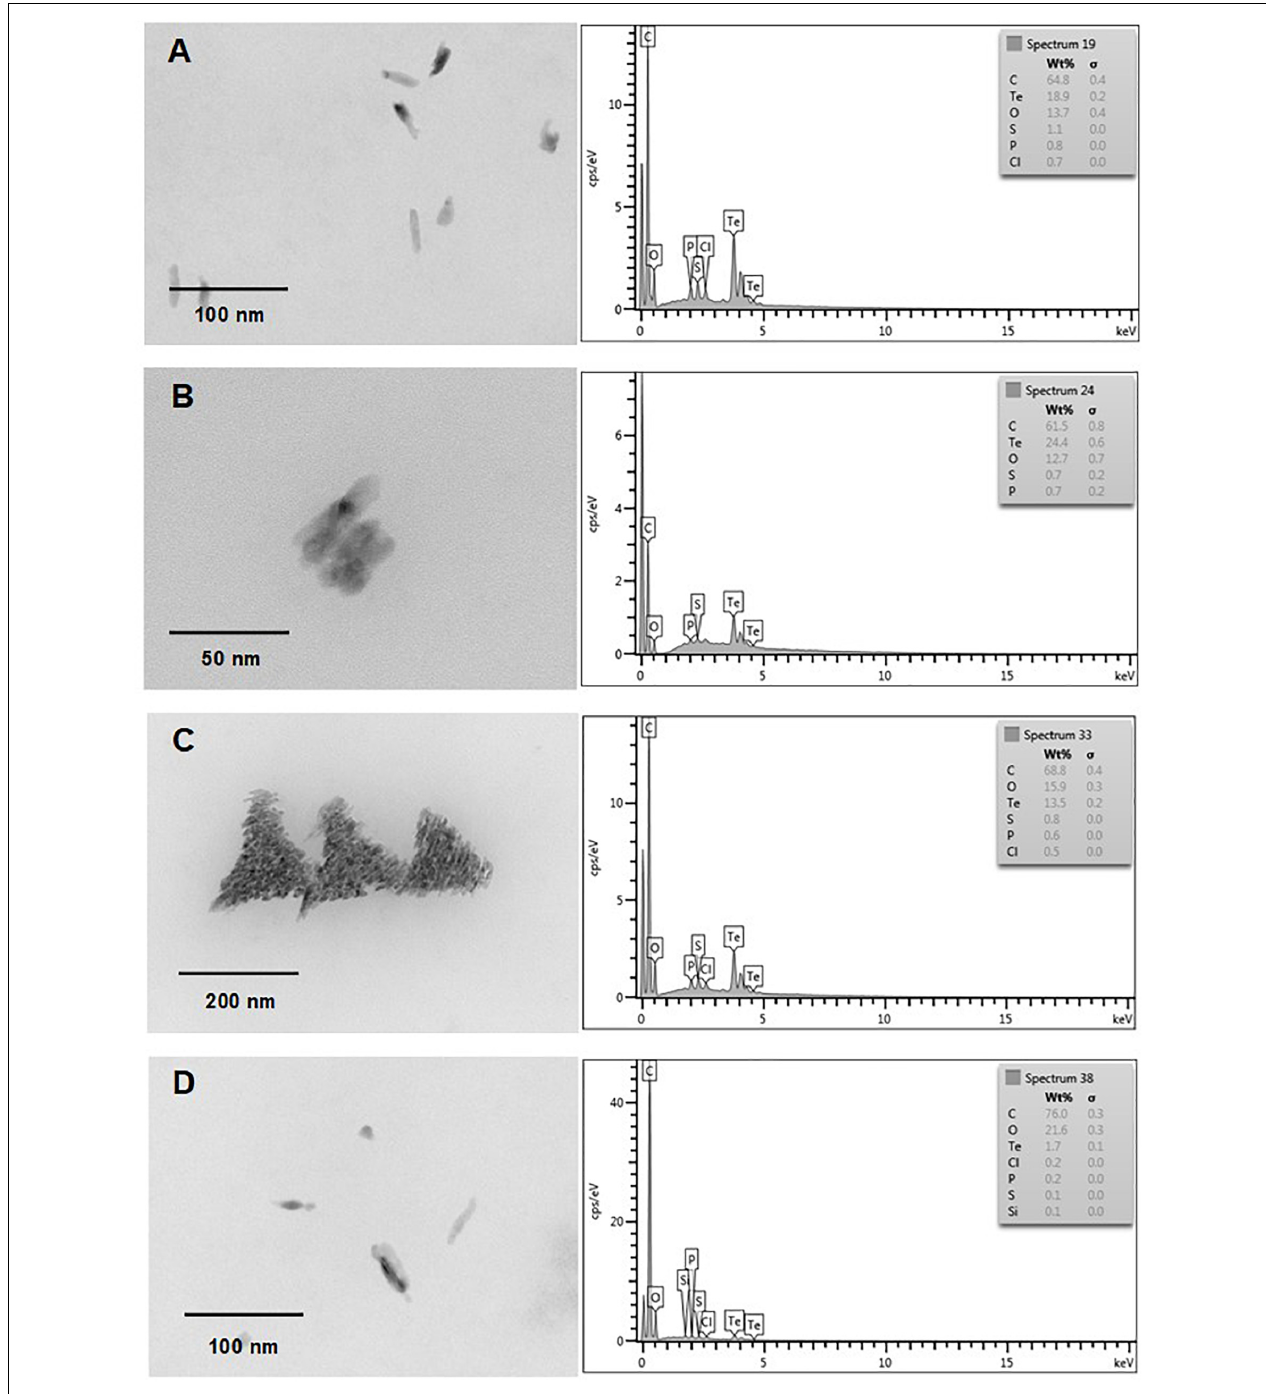
FIGURE 7 | In vitro , aerobic synthesis of TeNS by E. cloacae MF01 crude extracts. Electron micrographs (left) and EDS analysis (right) show TeNS synthesized under the following experimental conditions: (A) NADH / pH 8.0; (B) NADPH / pH 8.0; (C) NADH / pH 9.0; (D) NADPH / pH 9.0.